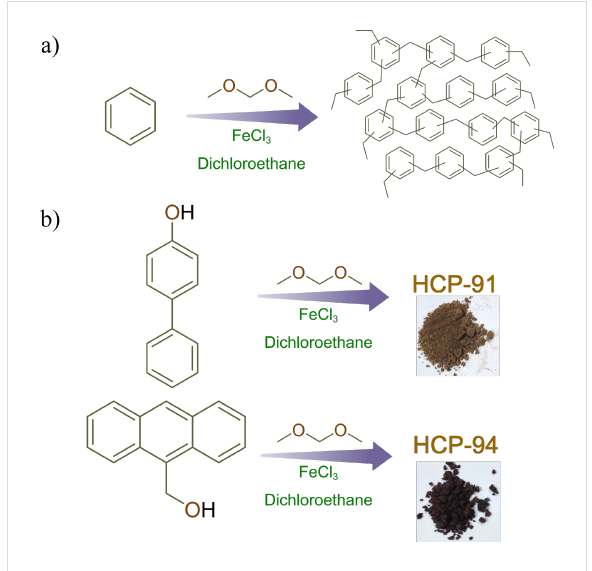
Figure 1: a) General synthesis scheme for hyper-cross-linked poly- mers (HCPs) and b) synthesis schemes for HCP-91 and